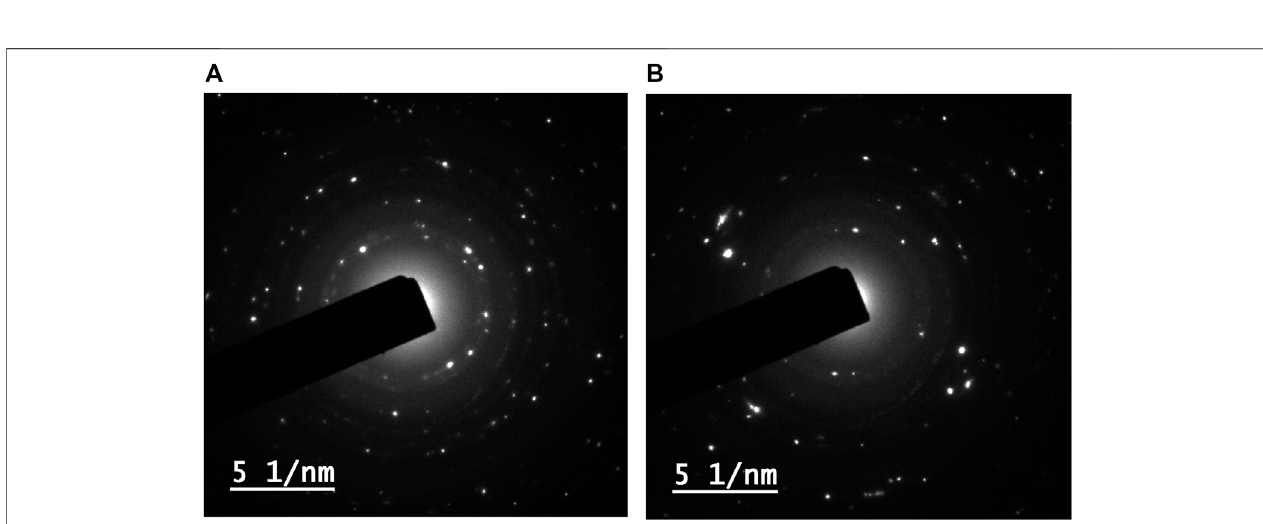
FIGURE 6| Transmission electron microscopy (TEM) image ofbiogenicZnO-NPs. (A) Ethanolextract of S. chirayita leaves and (B) methanol extract of S. chirayita leaves.